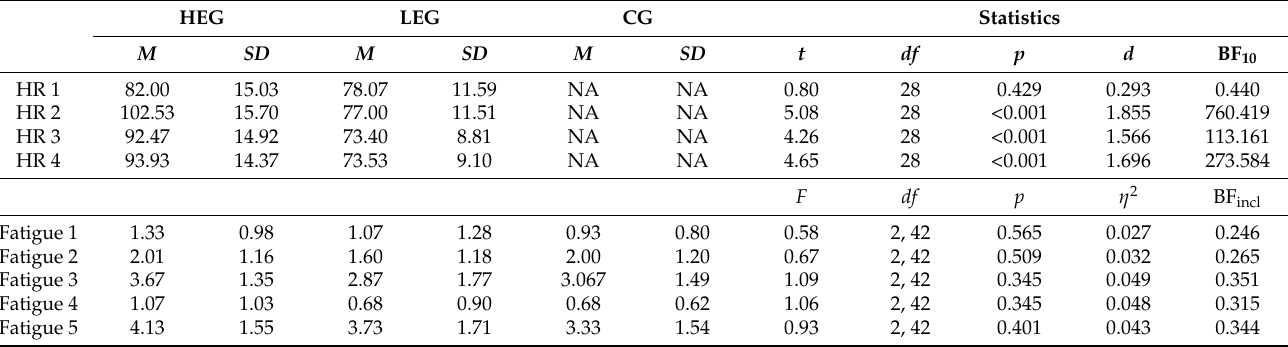
Table 3. Group comparisons (independent t -tests and one-way ANOVA) of heart rate and subjective hand fatigue ratings. HEG